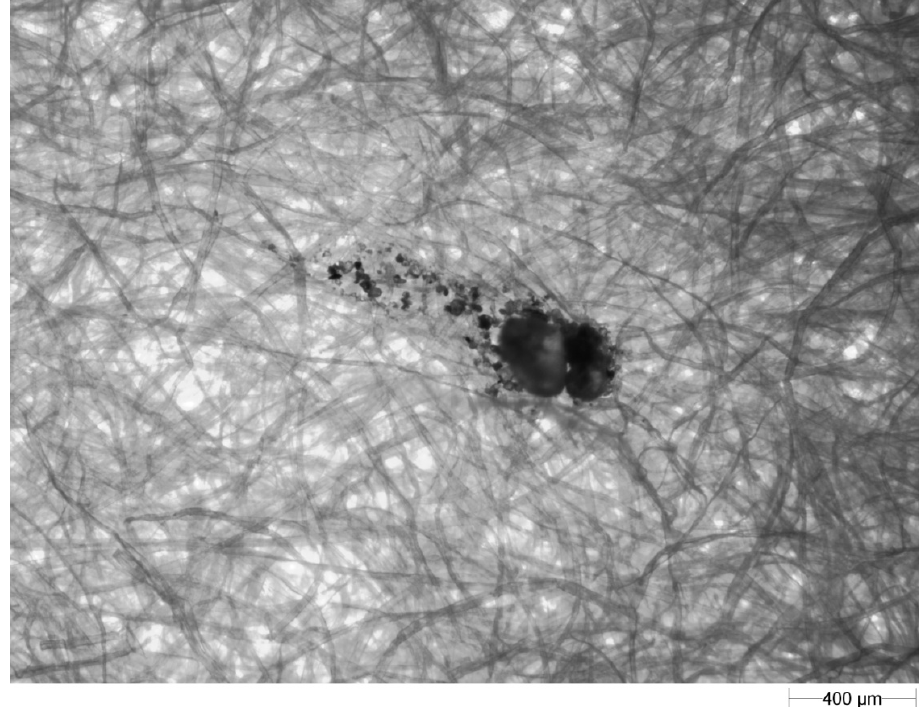
Figure 8. An example image of a ‘comet’ recorded on blotting